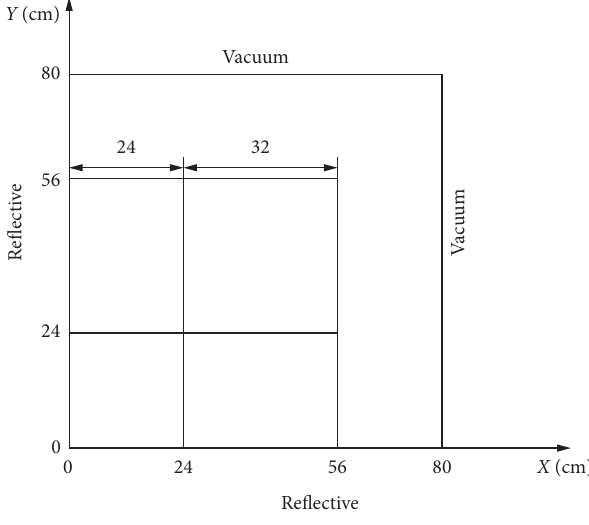
Figure 1: TWIGL benchmark. Table 1: Material parameters in TWIGL benchmark